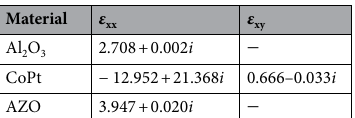
Table 1. Simulated dielectric constants of each layer at a wavelength of 658